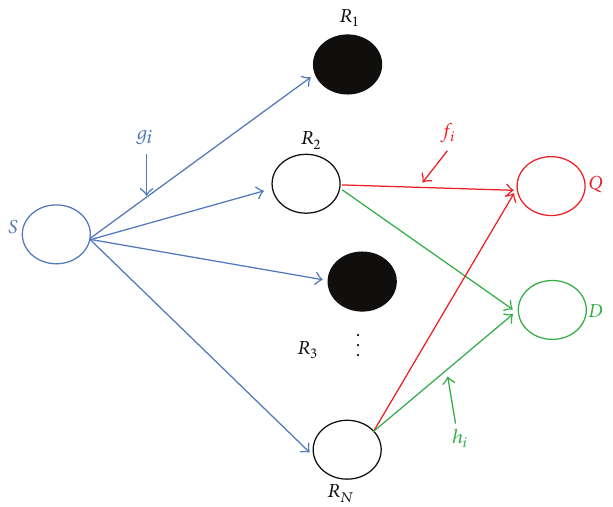
Figure 1: The system